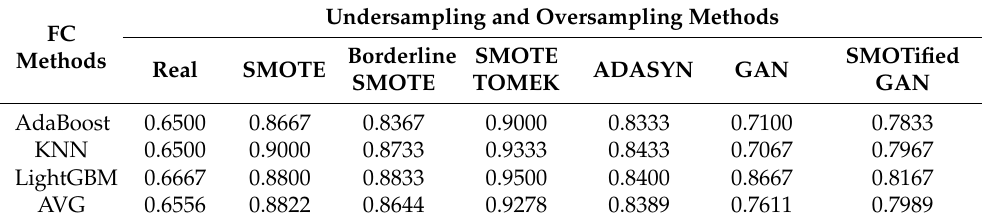
Table 2. Undersampling and oversampling with FDC recall